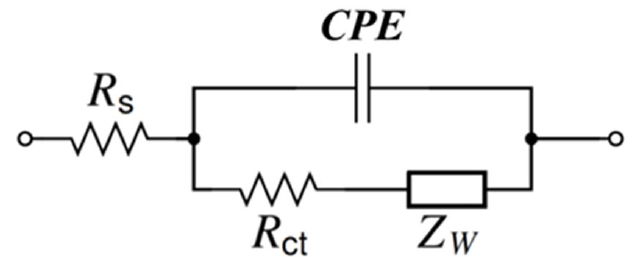
Figure 1. Representation of Randles equivalent circuit for the data fitting.